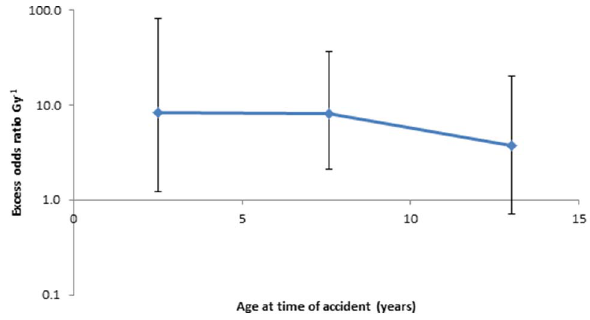
Figure 5. Variation of excess relative risk with age at the time of the accident (using 1 st regression calibration method, adapted from Kukush etal. [ 13 ] ). Other details as for Figure 4.